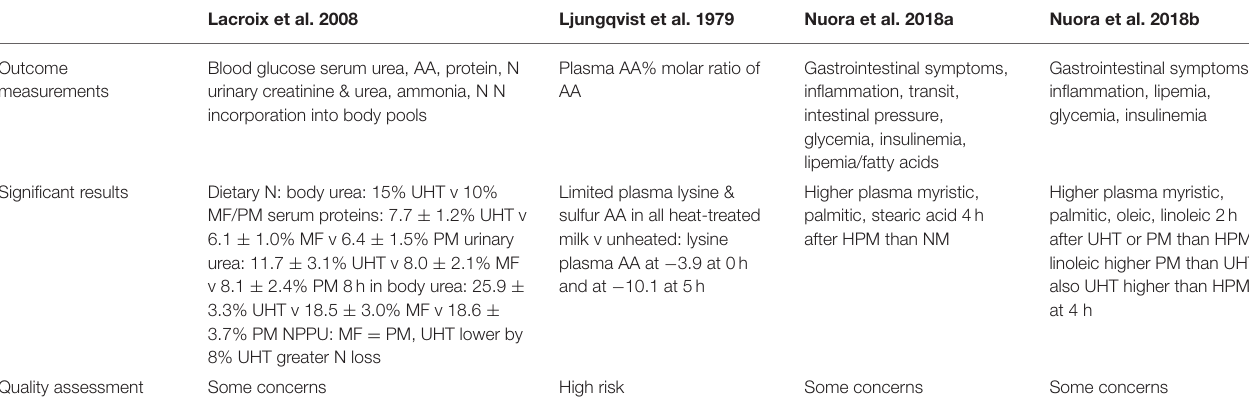
TABLE 4 | Findings of included studies assessing postprandial protein or lipid responses to heat treated milk in